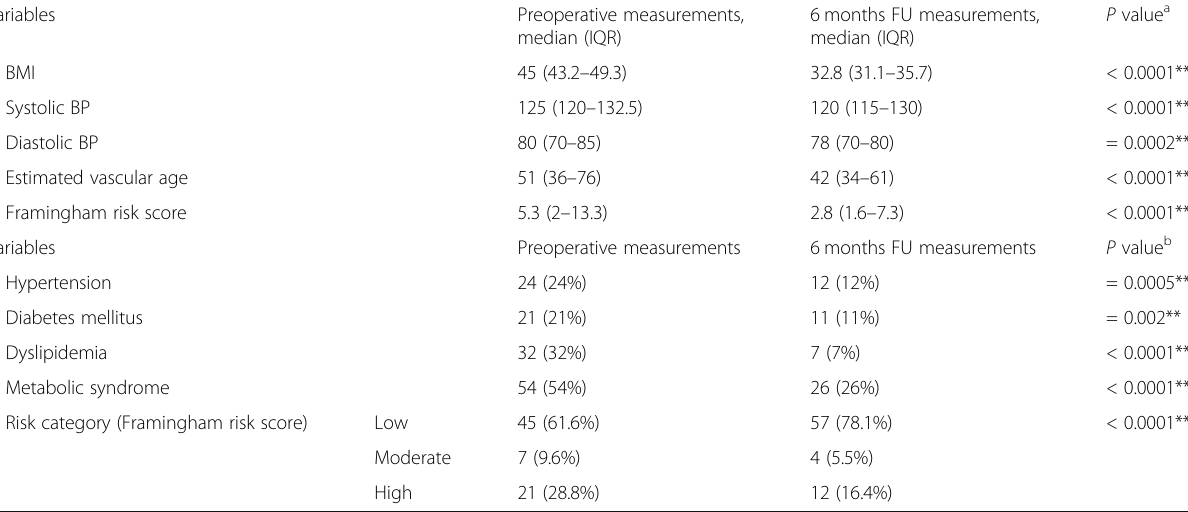
Table 1 Clinical characteristics preoperative and 6 months after bariatric surgery